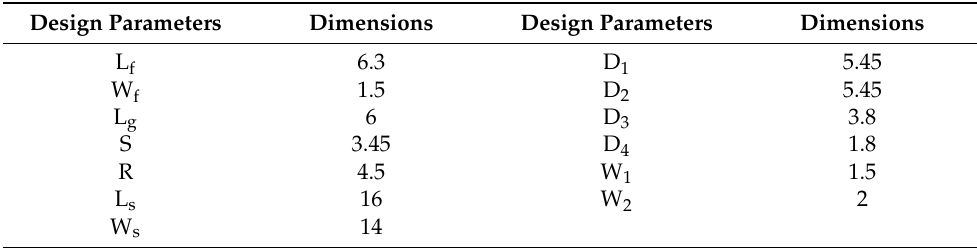
Table 1. Novel self-similar slotted monopole antenna with partial ground plane dimensions given in mm.